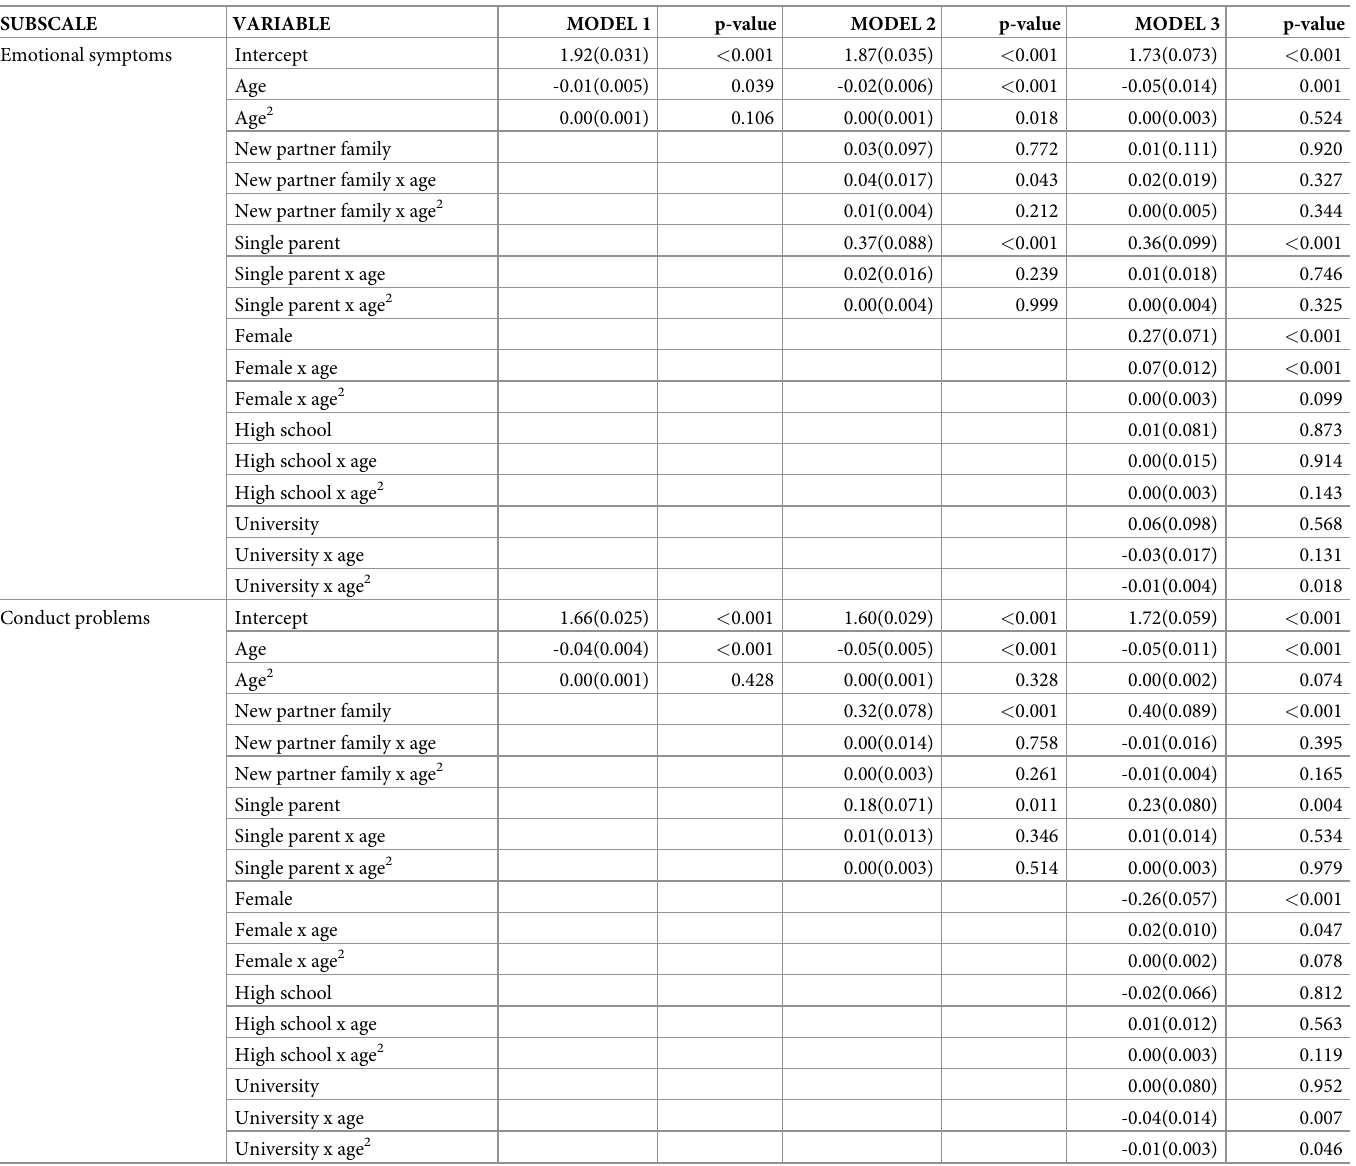
Table 4. Results of growth curve